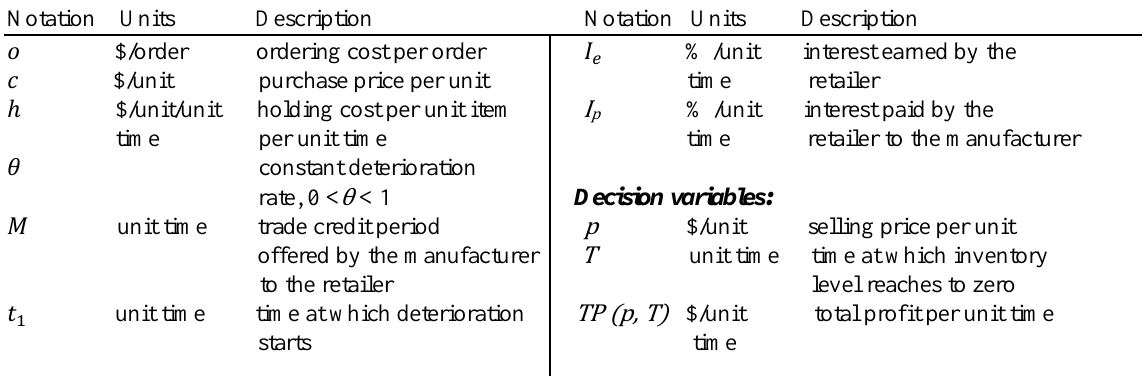
Table 1. Notations that are used in formulating the inventory